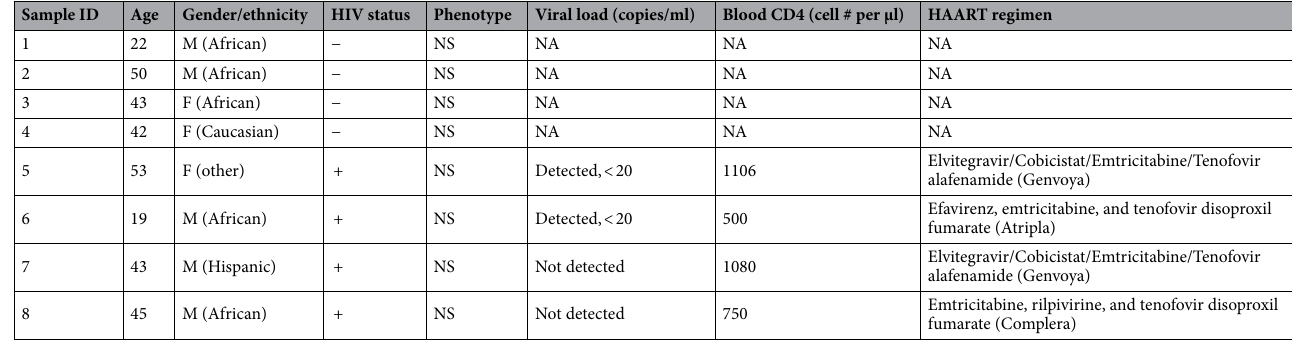
Table 1. Demographics of normal and HAART-treated HIV + Nonsmokers. NS nonsmoker, NA not